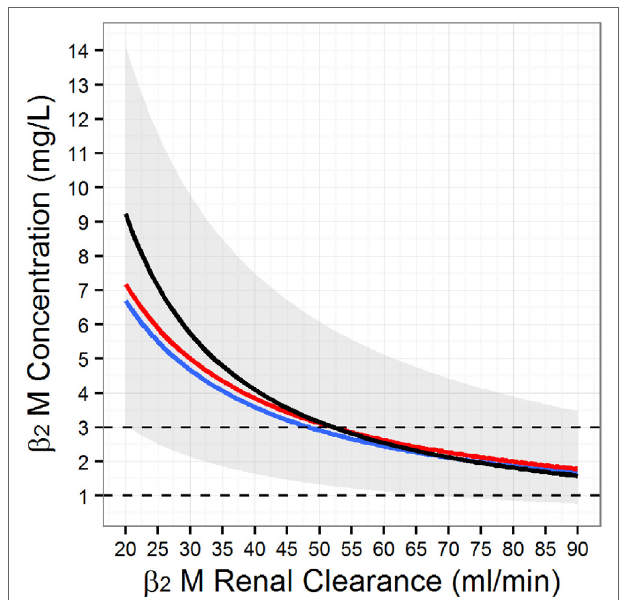
FigURe 3 | Simulated serum beta-2 microglobulin ( β 2 M) as a function of the glomerular filtration rate. To generate the figure we simulated 10,000 individuals from the population model for β 2 M kinetics (117) at different levels of renal function. At each level of renal function, we computed the mean (red line), the median (blue line), and the associated population 95% range (gray band). Finally, we superimposed the Chronic Kidney Disease Epidemiology Collaboration β 2 M estimating equation (black line)